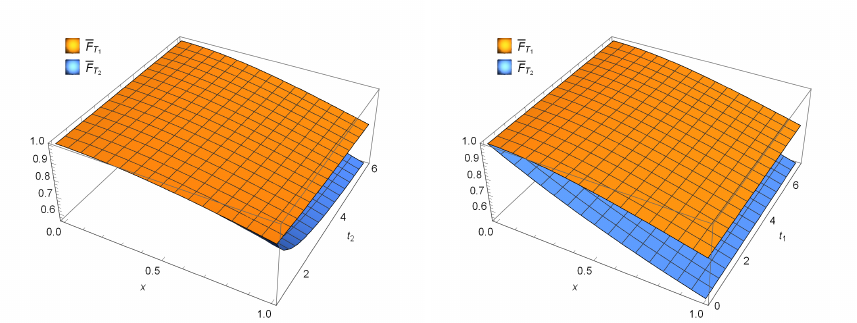
( t 1 , t 2 ) and RX T 2 ( t 1 , t 2 ) , for the t 1 = 1 ( left ) and 4:4 4:4